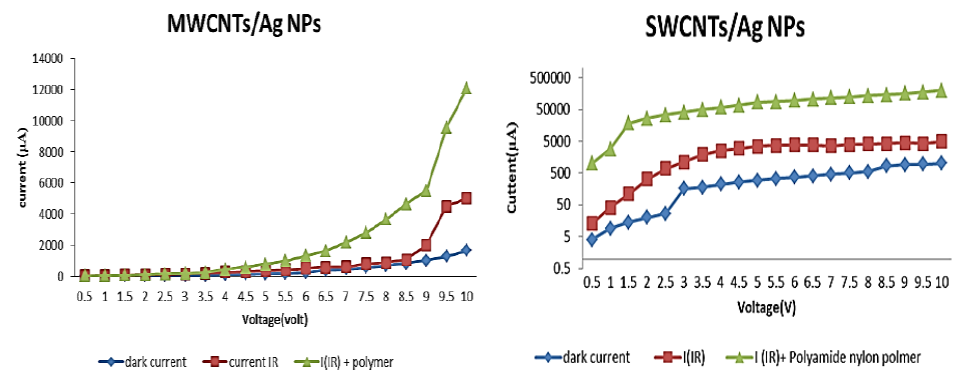
Figure 9c: The variation ofֹ the IR photo-current ofֹ the fabricated photoconductive detector with coating polymer for SWCNTs/Ag NPs and MWCNTs/Ag NPs.